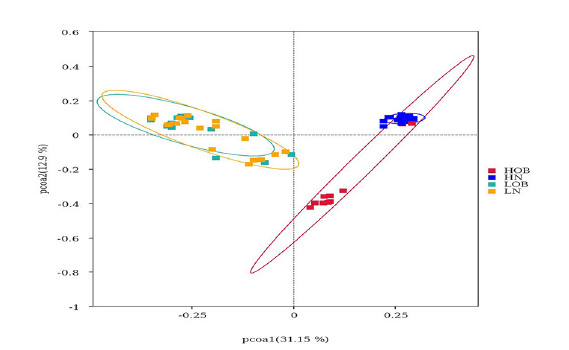
FIGURE1 Beta diversity analysis based on UniFrac analysis. Red dot represents the high altitude obese children (HOB) group. Blue dot represents the high altitude normal weight children (HN) group. Green dot represents the low altitude obese children (LOB) group. Orange dot represents the low altitude normal weight children (LN) group. Circles in red, blue, orange, and green represent different periodontal bacterial community clusters, respectively. LN, low-altitude obese children; LOB, low-altitude obese children; HN, high-altitude normal weight children; HOB, high-altitude obese